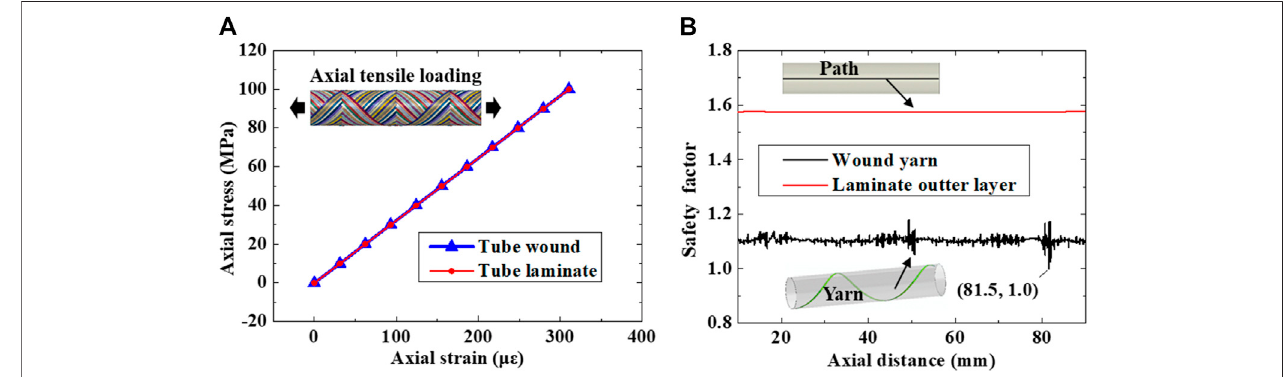
FIGURE 9 | The mechanical response of wound and laminated tubes under global axial tensile loading. (A) the global tension moduli; (B) the safety factor of shear stress.